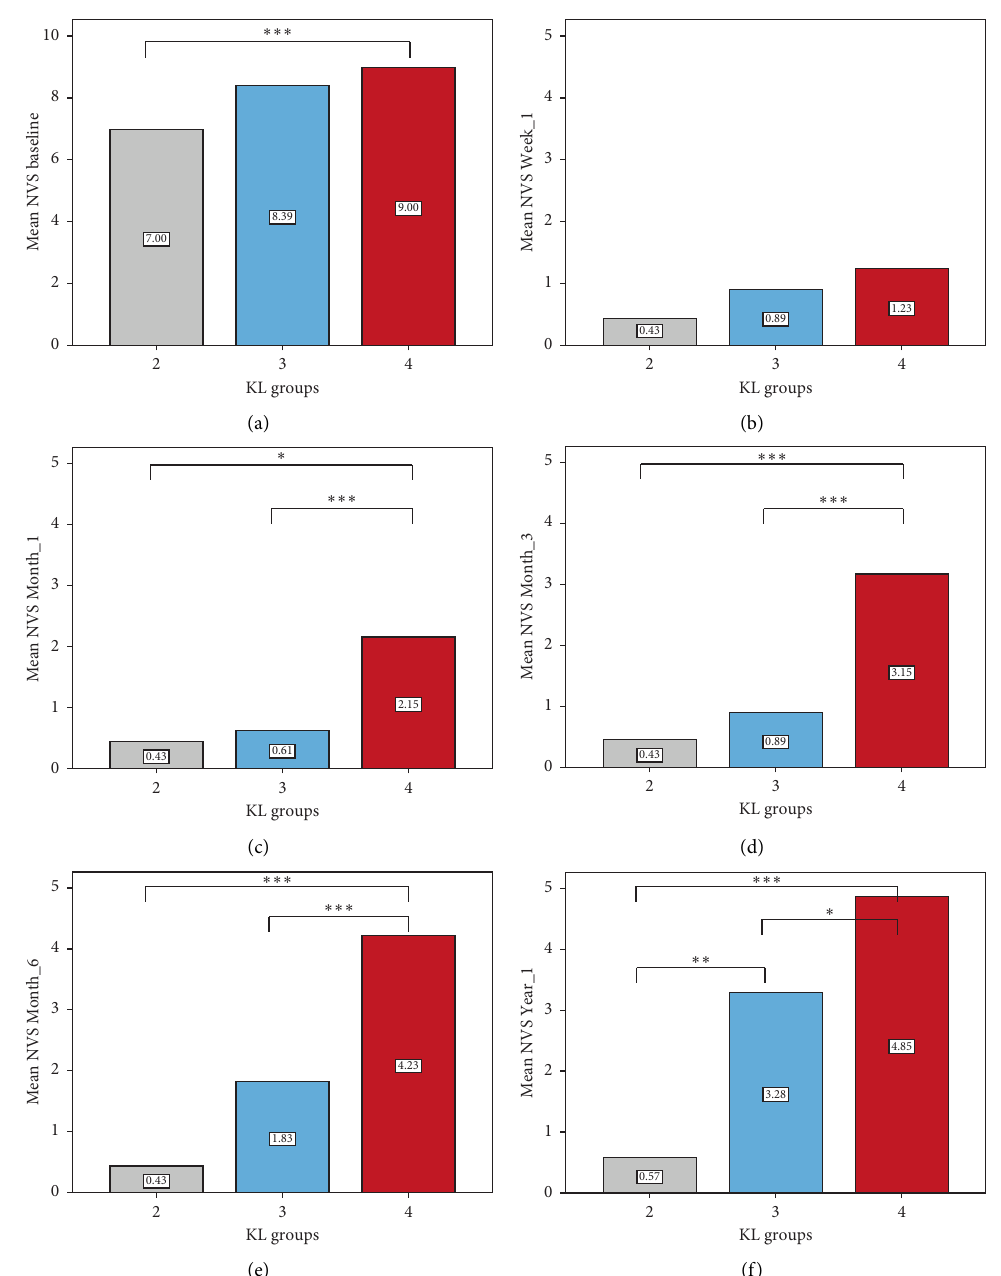
Figure 3: Bar chart illustrating mean NVS scores prior and during the follow-up period across the three osteoarthritis groups (KL-2, KL-3, and KL-4) (note: ∗∗∗ p < 0 . 005, ∗∗ p < 0 . 01, and ∗ p < 0 . 05 after Bonferroni